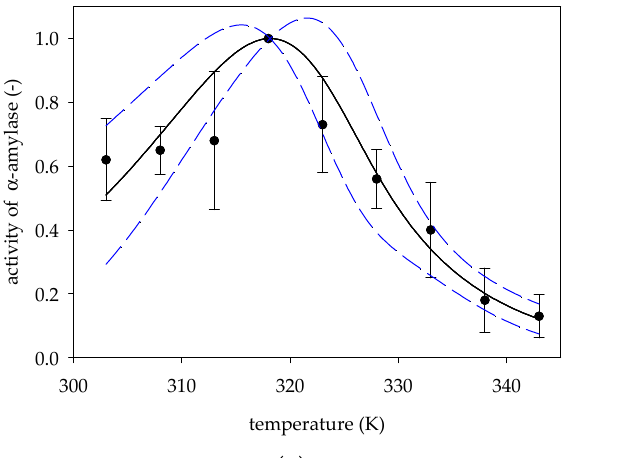
experimental data, (solid line) Equation (6); (dotted line) 95% confidence band.